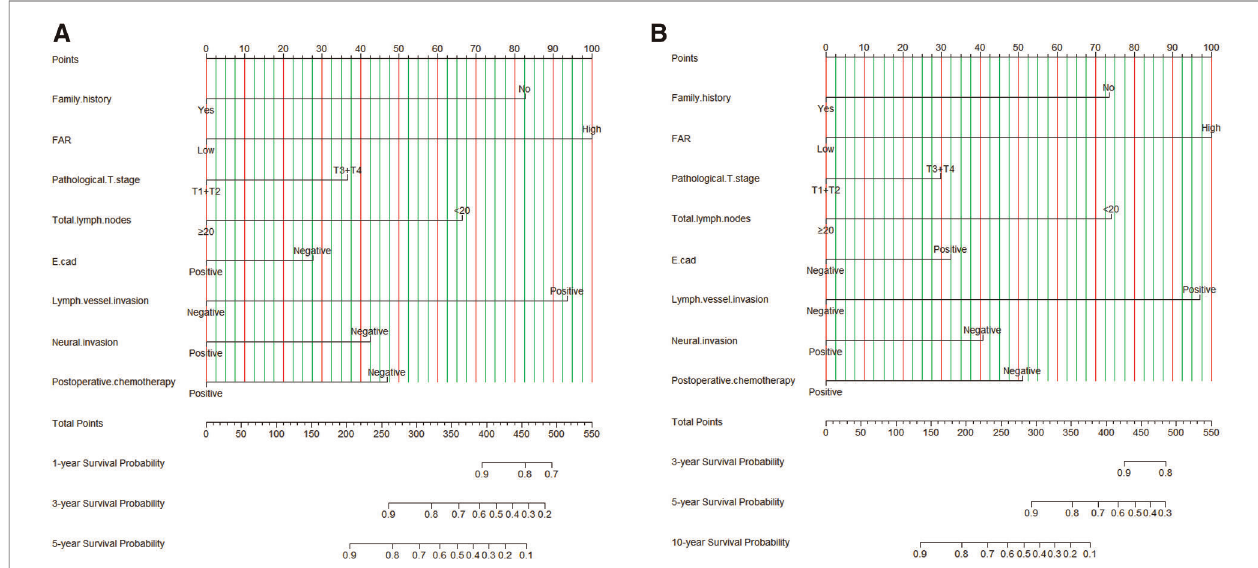
FIGURE 3 | FAR based nomogram for predicting disease free survival (DFS) and overall survival (OS). ( A ) FAR based nomogram for predicting DFS; ( B ) FAR based nomogram for predicting OS.